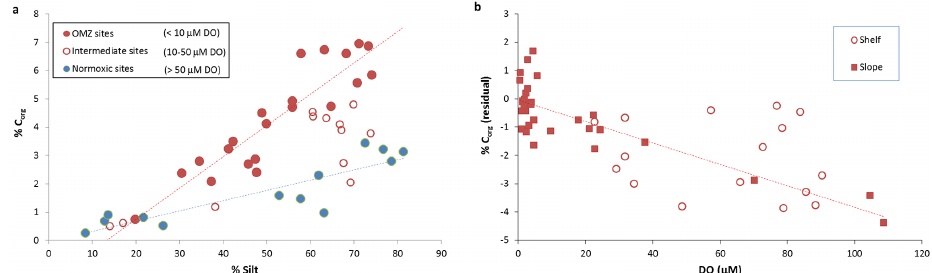
Figure 9. (a) A plot of organic C content (%C org ) against percentage by volume of silt (%Silt) for sediments from shelf and slope sites within the OMZ (closed blue circles; here defined by DO <10µM), and with normoxic (here defined by DO >50µM) and intermediate (DO = 10–50µM) bottom-water oxygen concentrations (at the time of sampling, intermonsoon). Dashed lines indicate linear regression results for the OMZ and normoxic sites. (b) A plot of residual C org values (departure from OMZ regression line in panel (a) for slope (>200m; red circles) and shelf (<200m; open circles) sites. Dashed line indicates linear regression results for all slope sites.